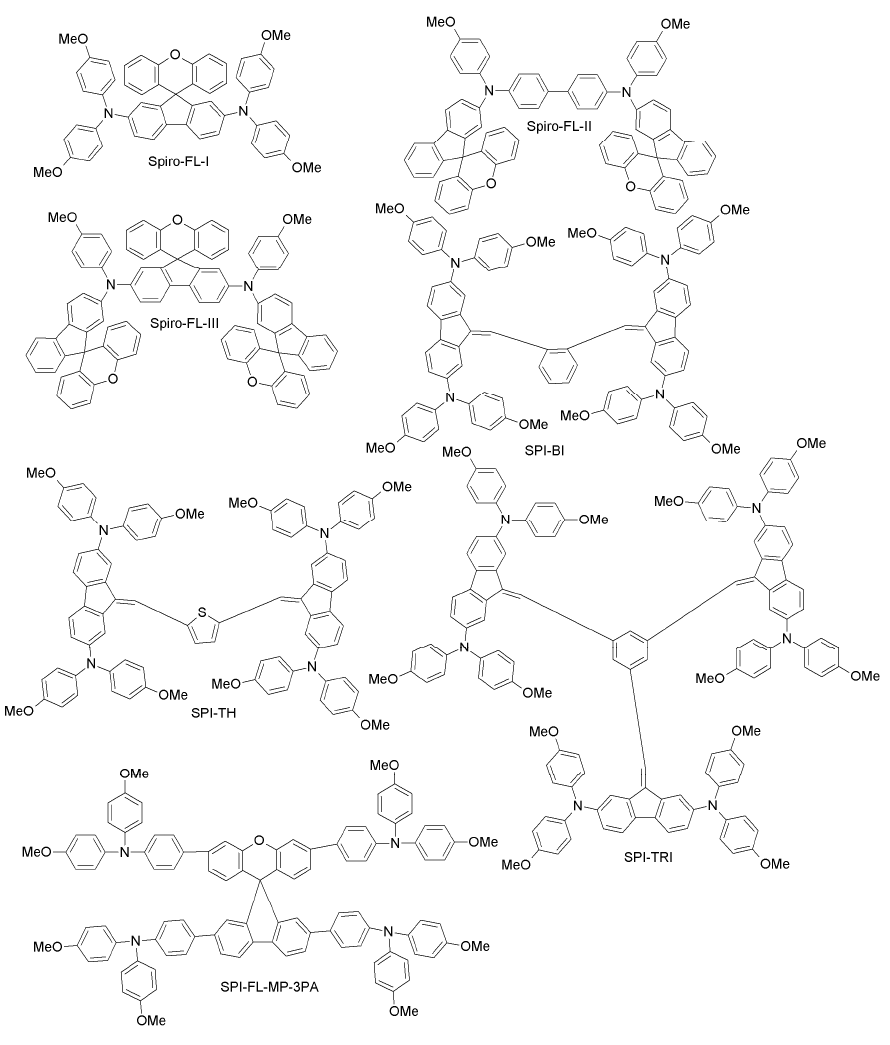
Figure 12. Spiro-fluorene-based HTMs (1).